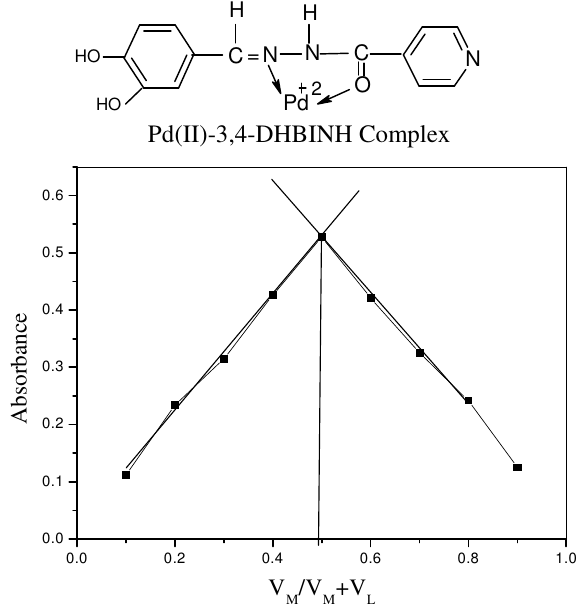
Figure 5. Job’s method of continuous variation of Pd(II) - 3,4-DHBINH complex; Pd(II) and 3,4-DHBINH: 1.0 mL of 1.0×10 −4 M; pH:3.0; λ